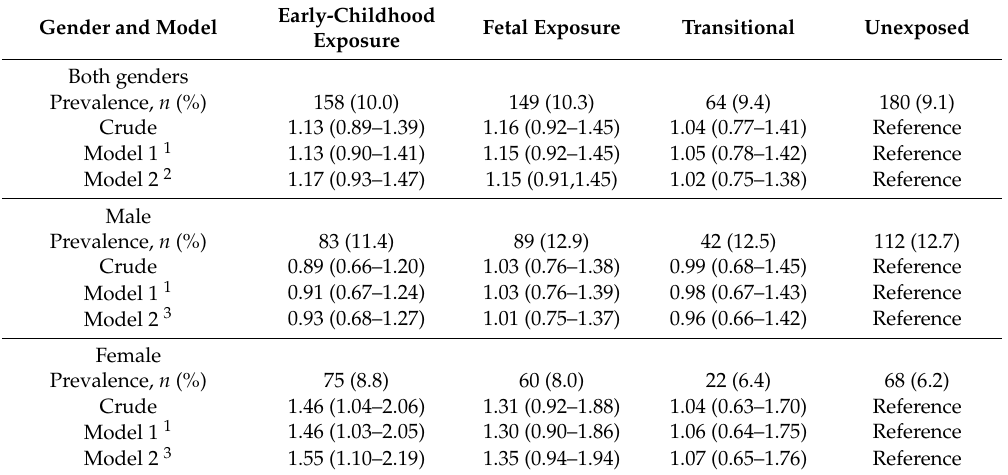
Table 3. Associations of famine exposure with the risk of diabetes in a Northeastern Chinese population.